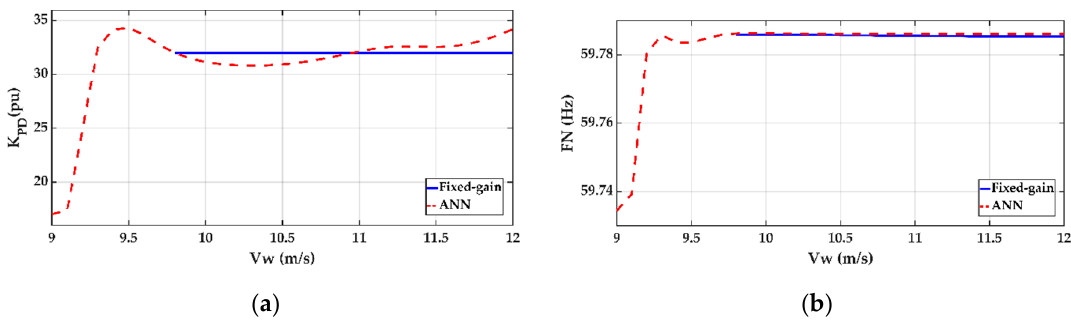
Figure 14. Droop gain K PD and frequency nadir from the ANN-based controller and fixed-gain controller ( ∆ P Load = 30 MW and wind penetration = 29.4%) under different wind speeds. ( a ) Droop gain K PD and ( b ) frequency nadir (FN).